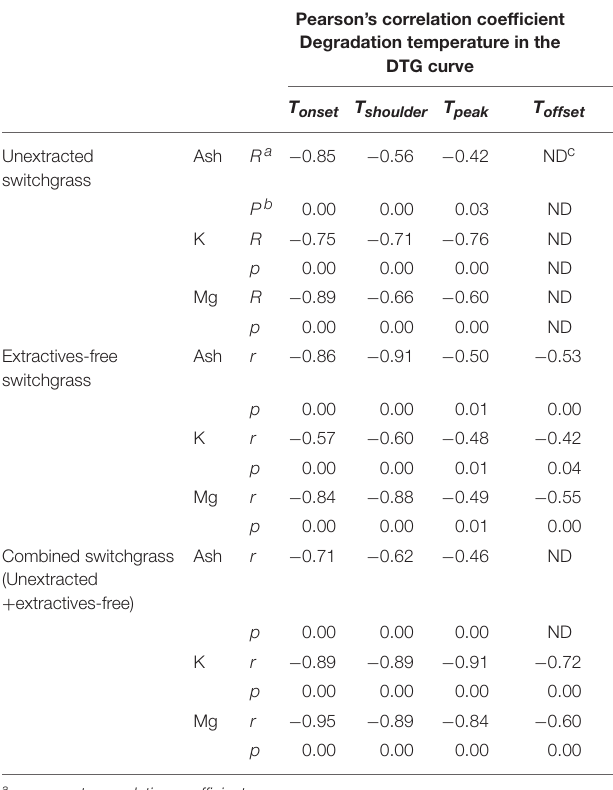
TABLE 1 | Pearson’s correlation between inorganic compounds and temperatures at derivative TG